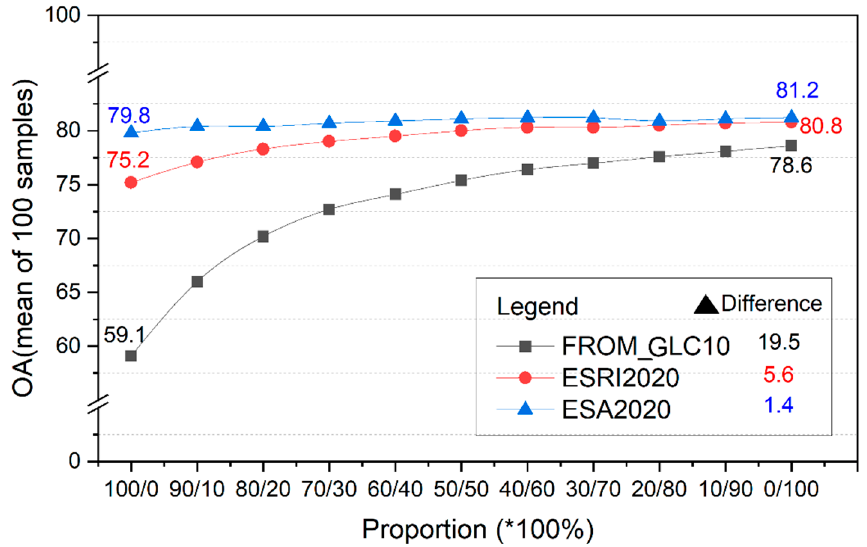
Figure 11. The mean OA value of 100 samples for the different mixing ratios of the field collection points and the manual densification points.